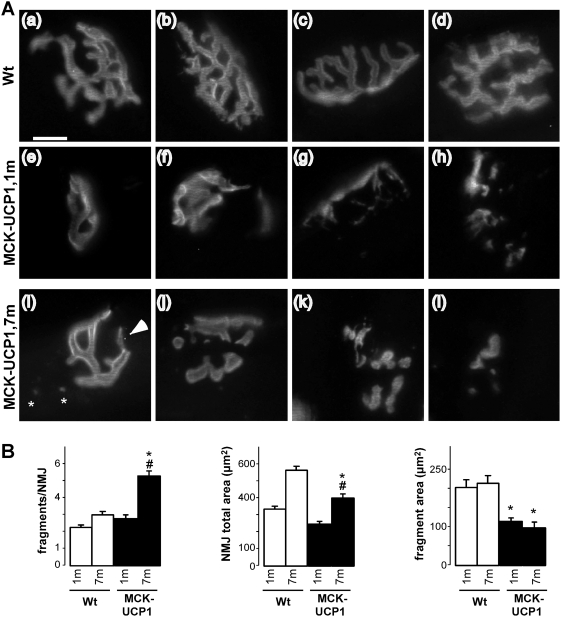
Aging MCK-UCP1 mice show progressive NMJ deterioration.A: representative photomicrographs showing NMJ morphology in gastrocnemius from wild-type (Wt) or MCK-UCP1 mice. Note the pretzel-shaped morphology of wild-type NMJs either at 1 month (a, b) or 7 months of age (c, d). In 1-month-old (1 m) MCK-UCP1 mice, NMJs appeared smaller and, in some rare cases, fragmented (e-h). At 7 months of age (7 m), thinner cisternae (arrow in i), ectopic AchR clusters (star in i), fragmented NMJs (j,k) and degenerated postsynaptic apparatus (l) were observed. Scale bar, 20 µm. B: quantitative morphometry of NMJs in gastrocnemius from wild-type (empty columns) or MCK-UCP1 (black columns) mice at 1 month (1 m) and 7 months (7 m) of age. *, p<0.05 vs corresponding wild type (n = 5 mice per group).